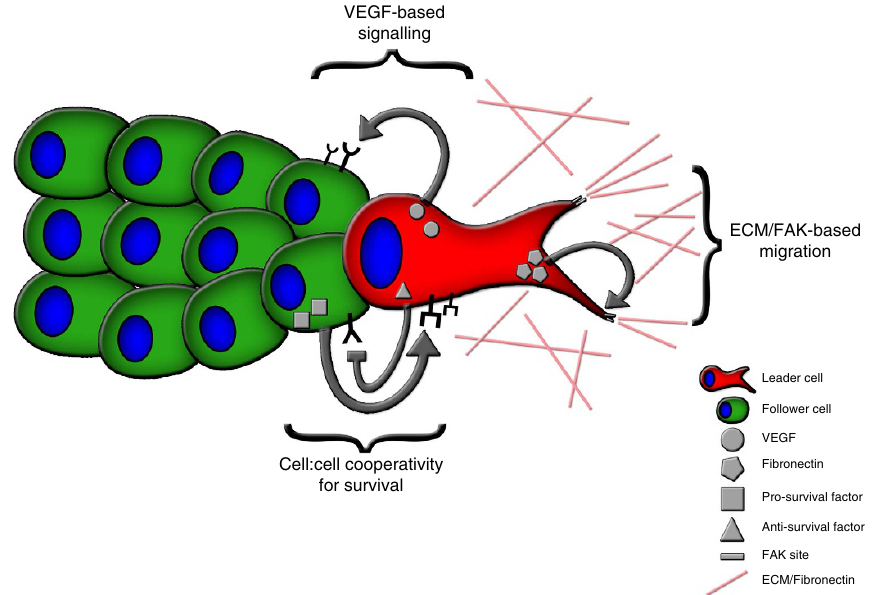
Figure 8 | Model of cell symbiosis during collective cancer cell invasion. A collective invasion pack shows phenotypic heterogeneity consisting of at least two subpopulations, a highly invasive leader cell (red) at the front of the pack and follower cells (green) immediately attached to and following the leader cell. The leader cell has increased VEGFA secretion, which promotes the motility and invasion of the follower cells. Other vasculogenesis signalling molecules are also utilized in the cell:cell communication between leader and follower cells, including VEGFR1, VEGFR2, VE-cadherin and Notch1 (not shown in the model for brevity); This atypical VEGF-based signalling allows for successful chain formation during invasion. Concomitantly, leader cells secrete excess fibronectin, which activates the canonical integrin/FAK pathway. This pathway allows for leader cells to create force to move the invasive pack forward into the microenvironment. Conversely, follower cells are a highly proliferative population that promote leader cell growth via a secreted factor, whereas leader cells secrete a factor that hinders follower cell growth. These data support a symbiotic relationship in the collective invasion pack in which the follower cells promote leader cell survival and leader cells promote follower cell